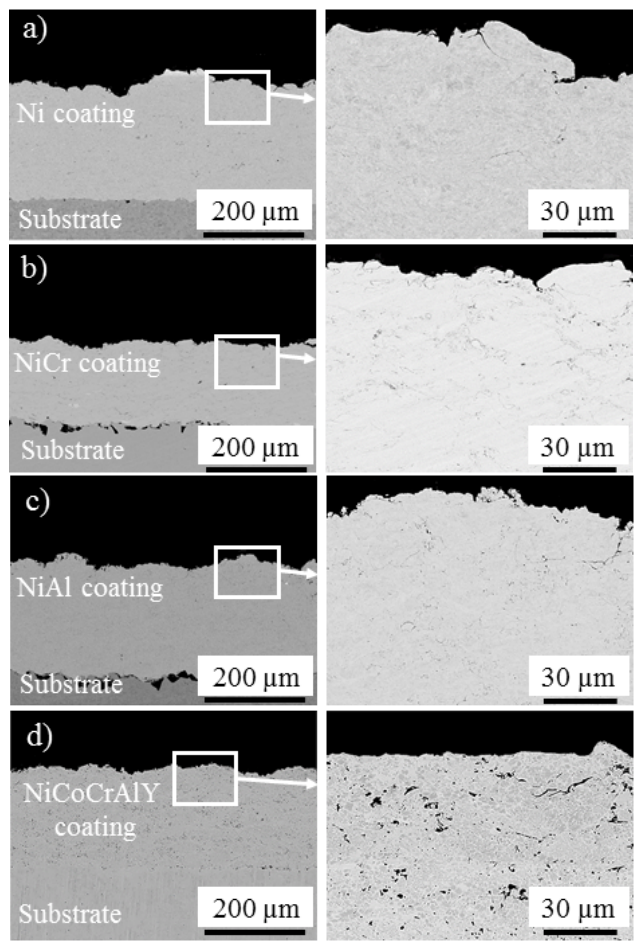
Figure 5. Back ‐ scattered SEM micrographs of cross ‐ sections of HVAF ‐ sprayed Ni ‐ based coatings: ( b ) NiCr, ( c ) NiAl and ( d )